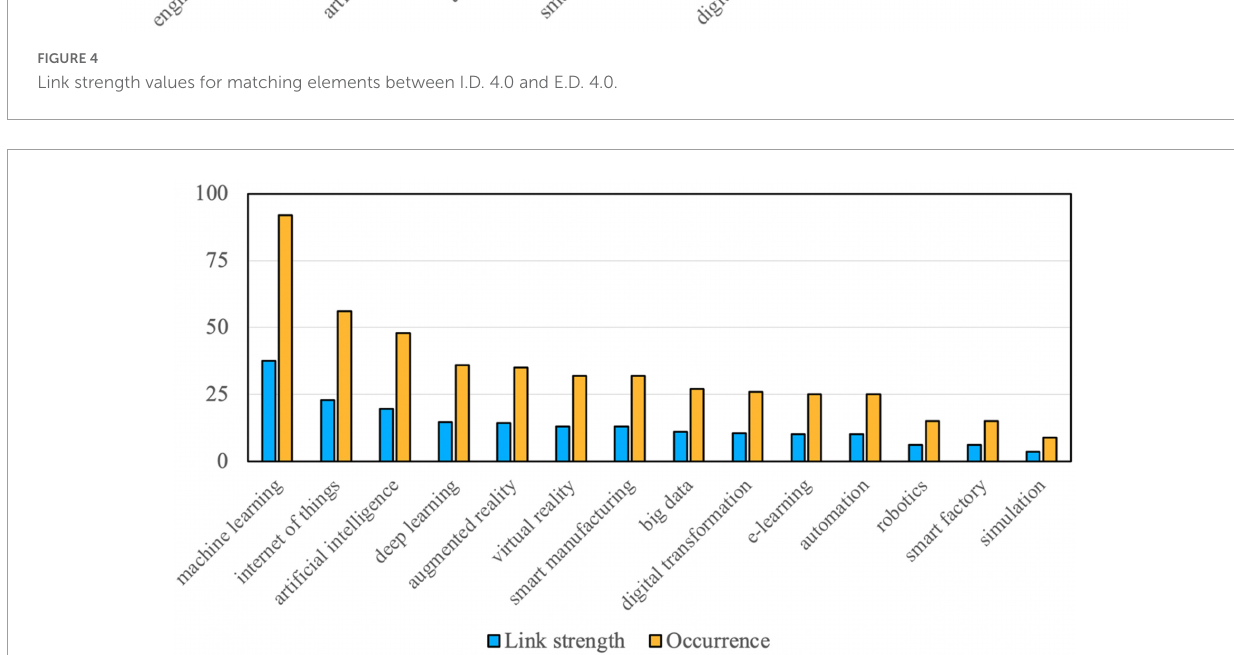
FIGURE5 Link strength and occurrence values for the identified clusters arising from our bibliometric